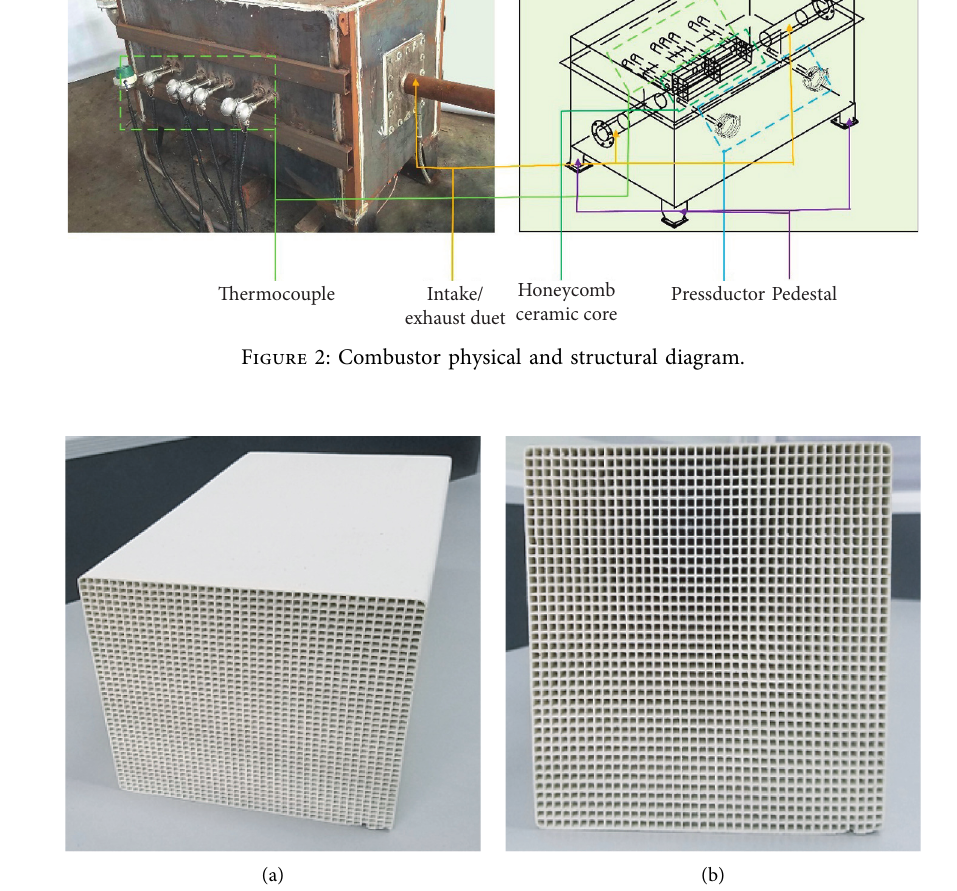
Figure 3: Thermal storage ceramic diagram. (a) Monolithic ceramics. (b) Section diagram of monolithic ceramics.